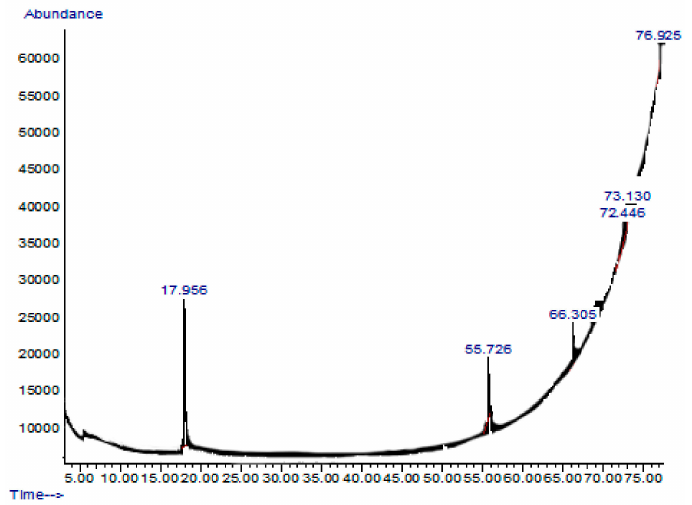
Figure 3. Chromatograms obtained from the gas chromatography-mass spectrometry (GC-MS) analysis of the ethyl acetate fraction of G.